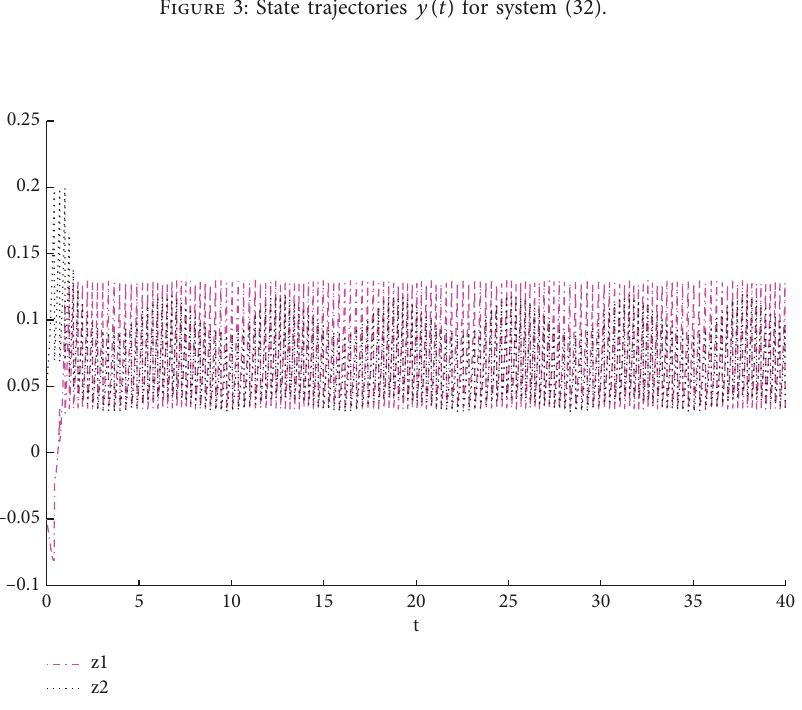
Figure 3: State trajectories y ( t ) for system (32).